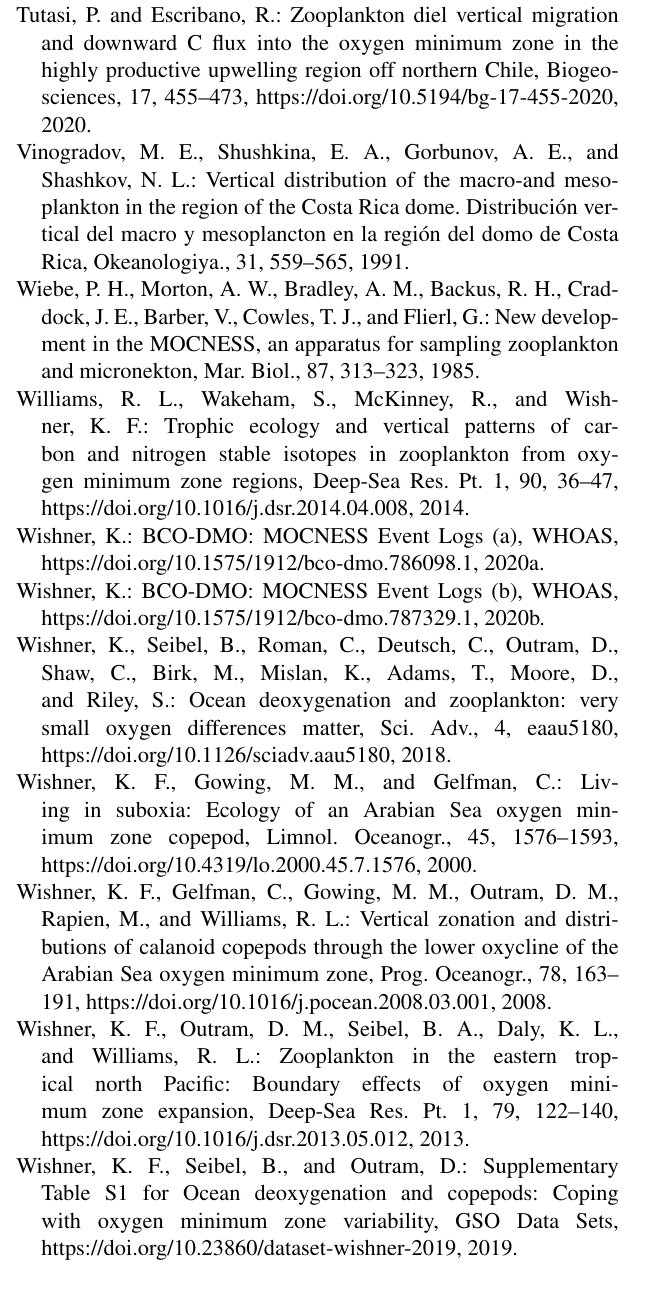
Table S1 for Ocean deoxygenation and copepods: Coping with oxygen minimum zone variability, GSO Data